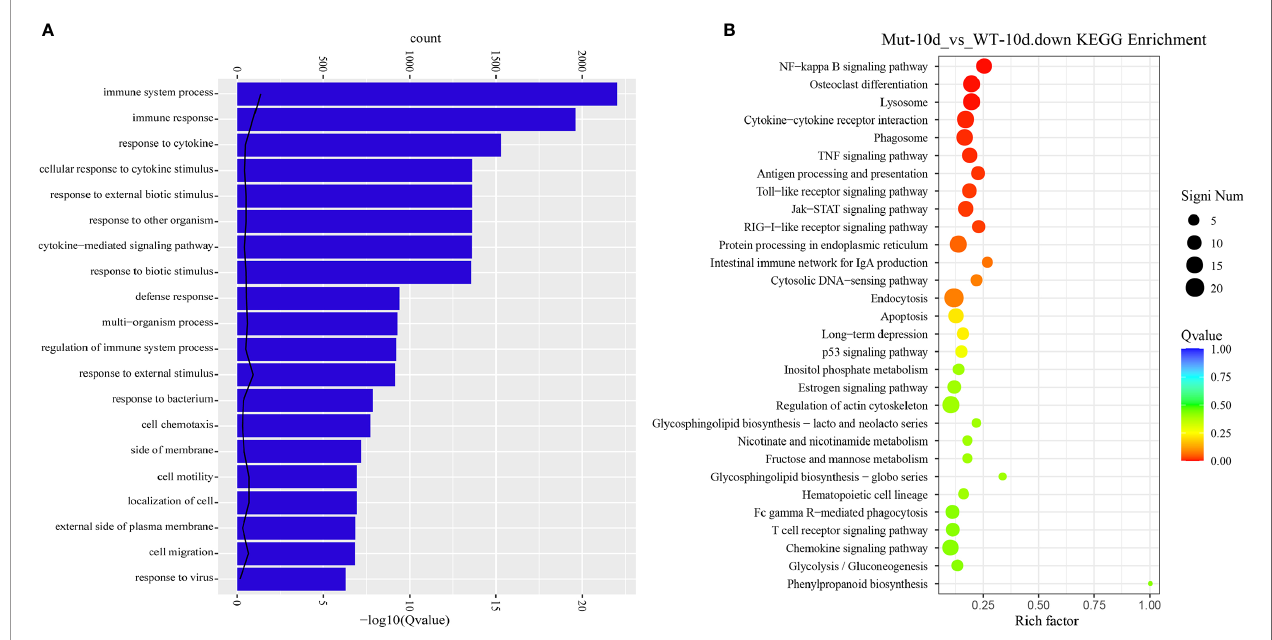
FIGURE 7 | GO functional enrichment and KEGG analysis from downregulated DEGs in Mut-10d_vs_WT-10d. (A) The top 20 signi fi cantly downregulated GO categories in Mut-10d_vs_WT-10d. The X - and Y -axes represent the signi fi cantly enriched GO terms and the corresponding number of DEGs, respectively. (B) The top 30 downregulated KEGG pathways in Mut-10d_vs_WT-10d. The numbers of DEGs in each pathway are counted, and rich factors and P -values are displayed.